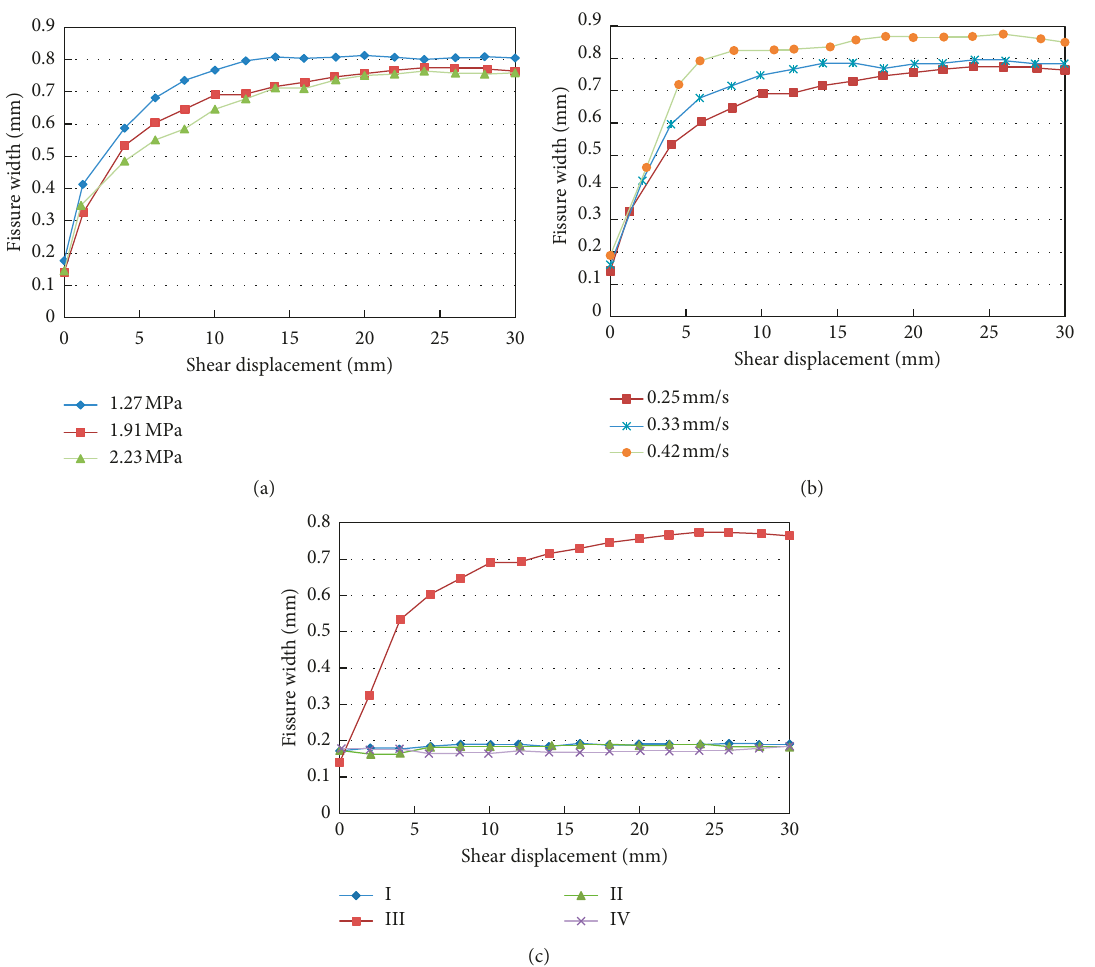
Figure 11: Evolution in fissure width with increasing shear displacement. (a) Increasing normal stress. (b) Increasing shear velocity. (c) Changes in the fissure plane combination